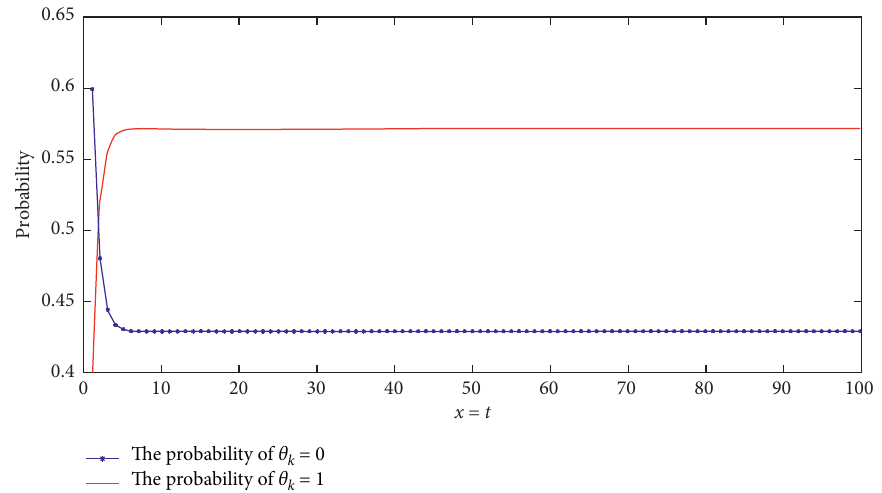
Figure 5: The change of Markov